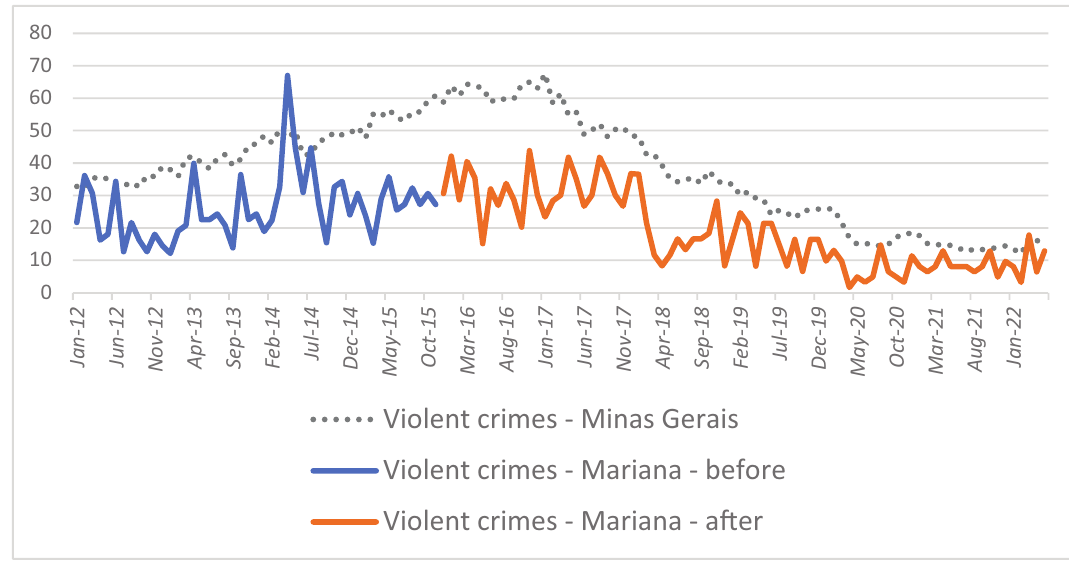
Figure 5. Rate of violent crimes per month, for Minas Gerais and Mariana – 2012- 2022 Source: Occurrences: Armazém Sisp (official data warehouse for Minas Gerais state public security system). Demographic data: IBGE.